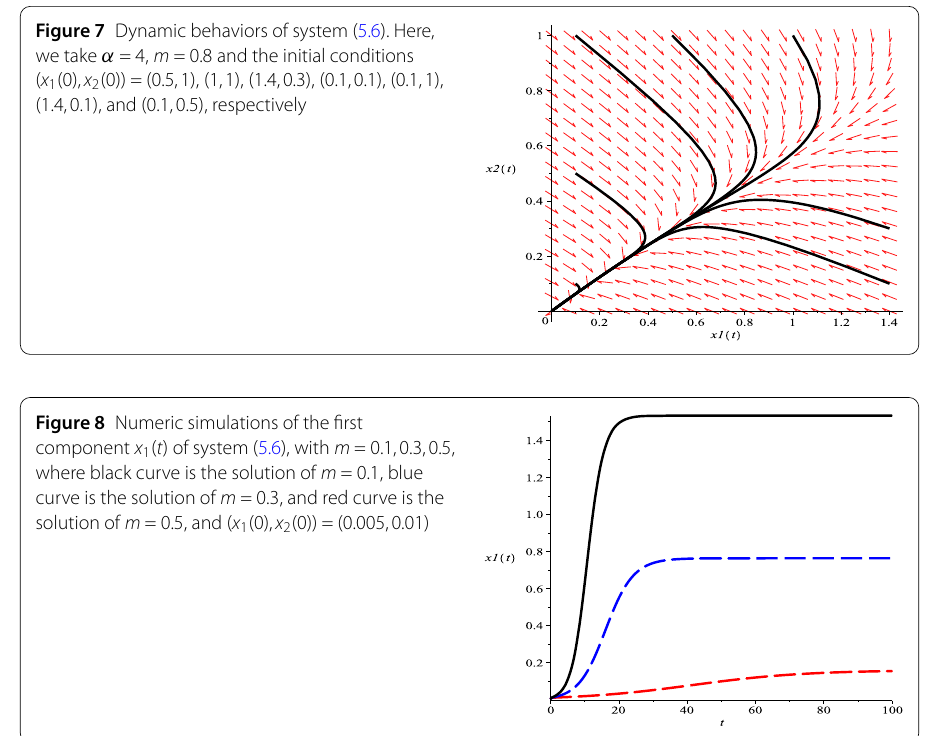
Figure 7 Dynamic behaviors of system (5.6). Here, we take α = 4, m = 0.8 and the initial conditions